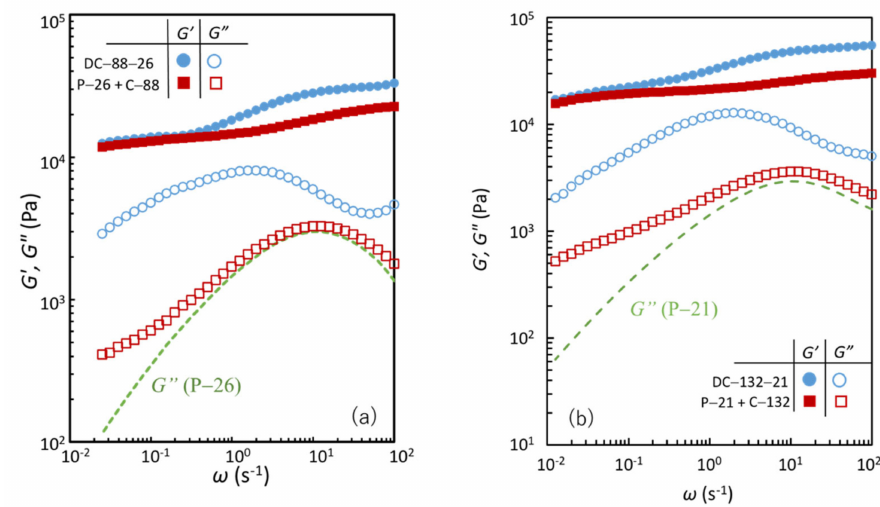
Figure 5. Comparison of the angular frequency ( ω ) dependence of storage shear modulus ( G (cid:48) ) and loss shear modulus ( G (cid:48)(cid:48) ) for ( a ) DC-88-26 and the summation of the corresponding data for C-88 and P-26, and ( b ) DC-132-21 and the summation of the corresponding data for C-132 and P-21. The G (cid:48)(cid:48) – ω curves of P-26 and P-21 in Figure 4 are shown for